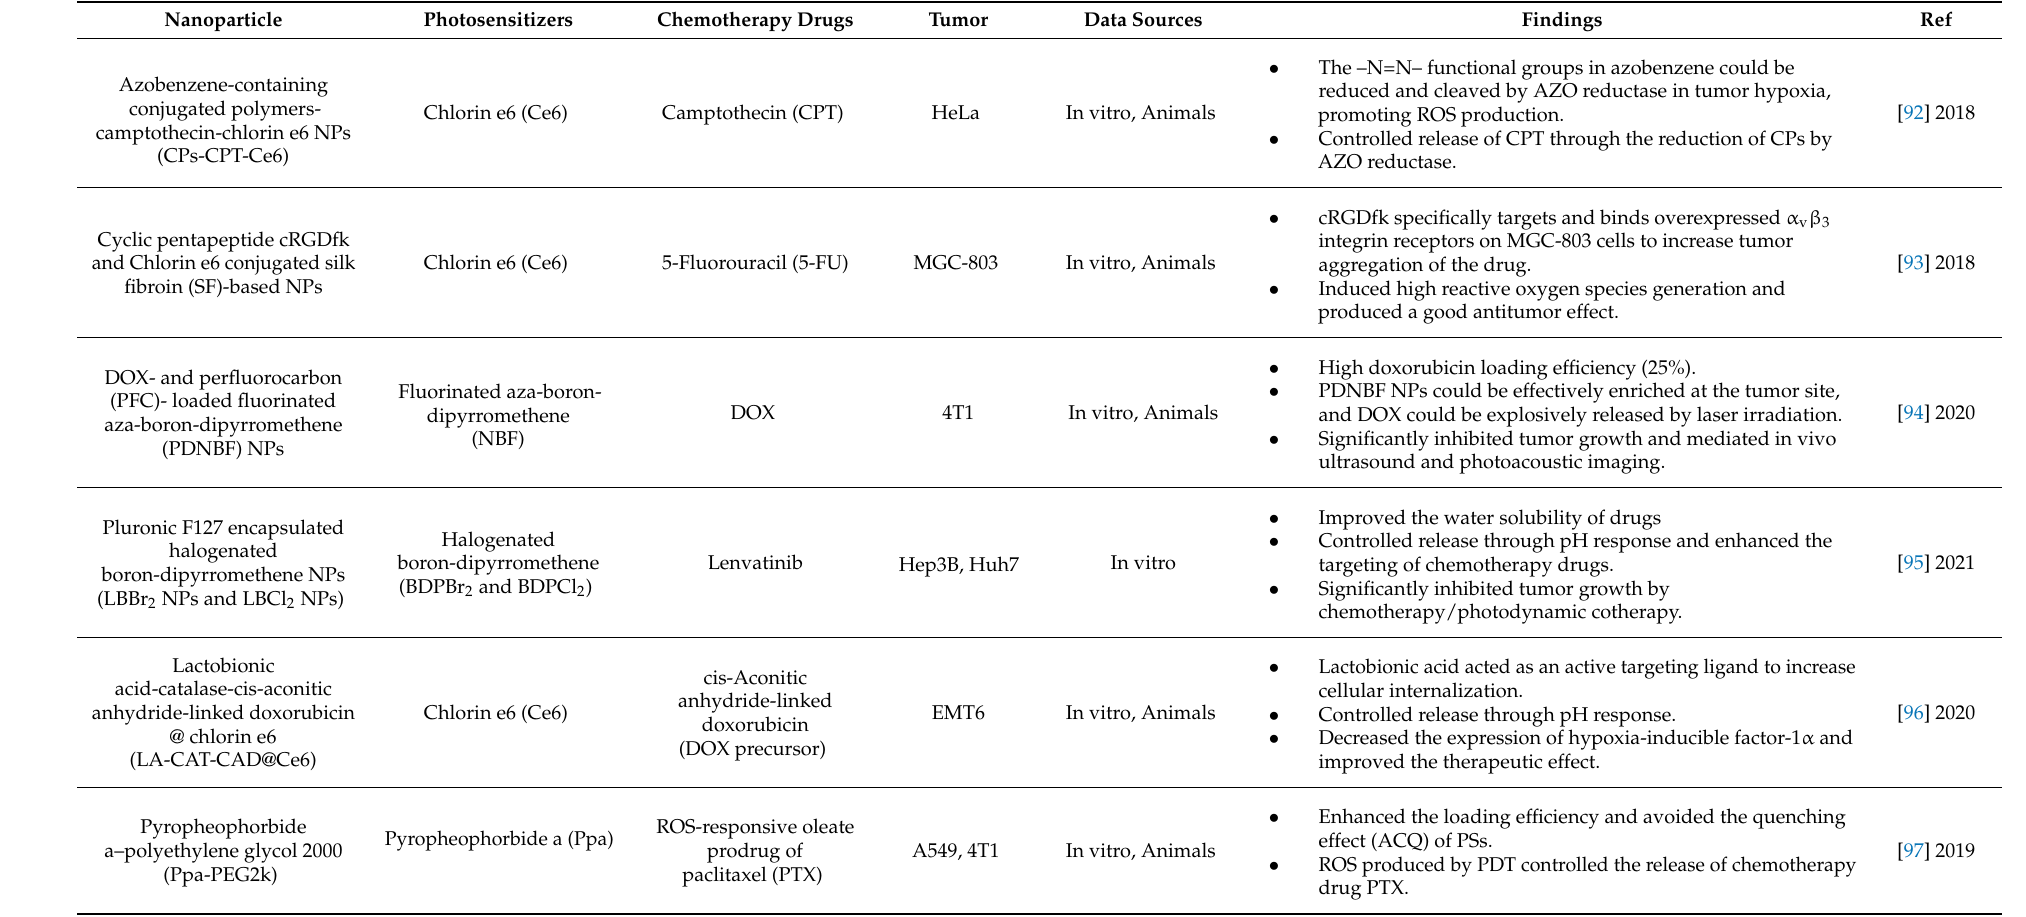
Table 1. Codelivery of photosensitizers and chemotherapy drugs based on